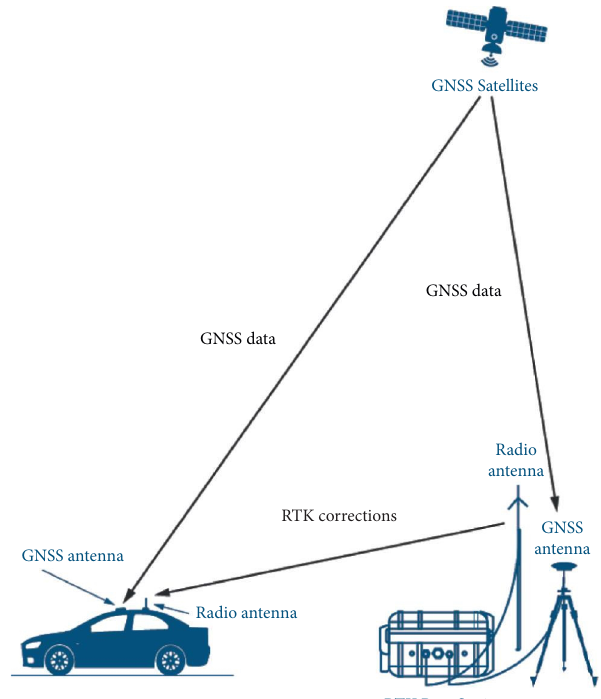
Figure 4: RTK (Real-Time Kinematic) for providing accurate positioning system and correcting the GNSS errors